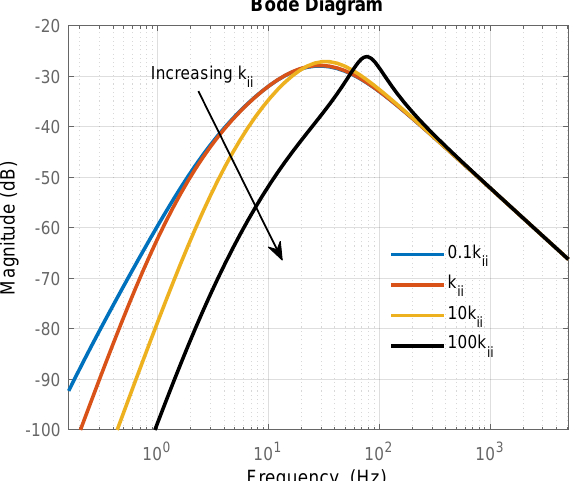
Figure 18. Time domain plot of grid side DC voltage to sensitivity of inner-controller proportional gain, k pi .